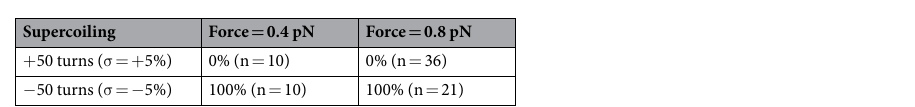
Table 1. Effect of DNA supercoiling on RepD nicking activity. 10-kb dsDNA templates with oriD were held using the magnetic tweezers at fixed amounts of either positive or negative supercoiling at two different forces (0.4 and 0.8 pN) while incubated with RepD (100 nM). The proportion of nicked DNA molecules was then counted by noting the change in DNA length after 10 minutes’